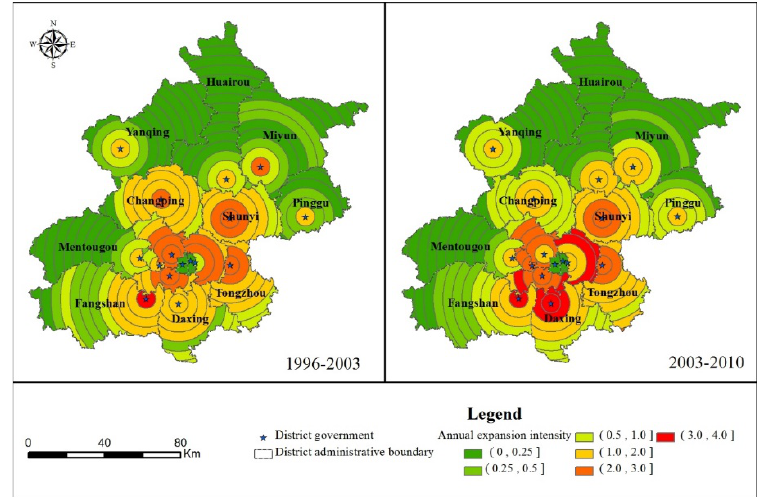
Figure 10. The annual expansion intensity in buffer rings around district and county governments.